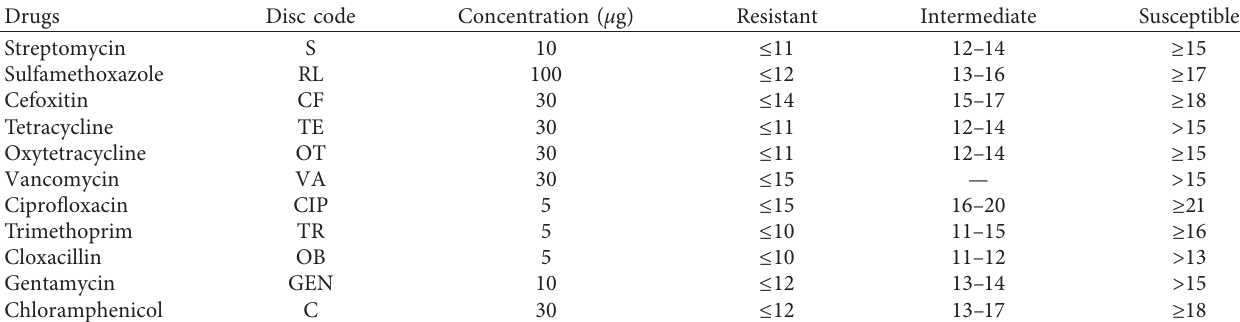
Table 1: Antibiotic disk used to test E. coli O157: H7 and their respective